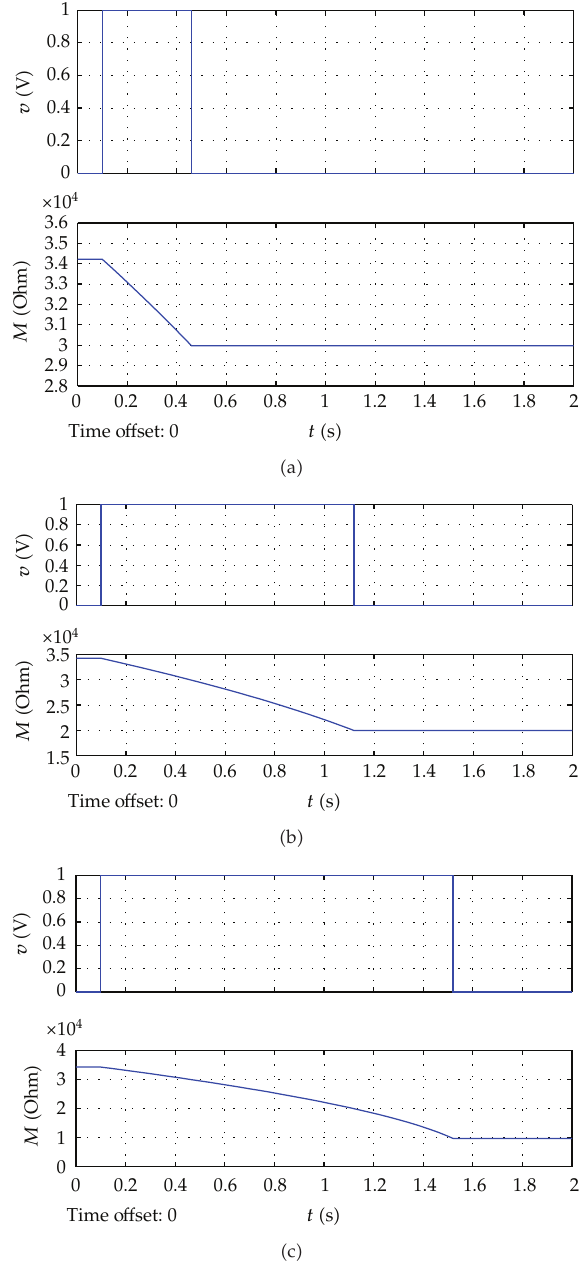
Figure 6: Three memristance states and the corresponding programming voltage